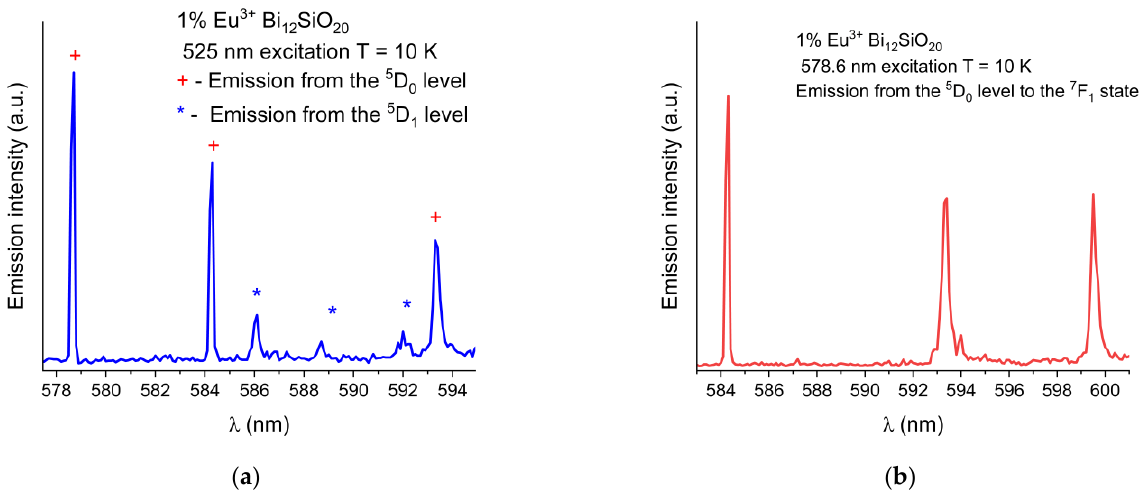
Figure 6. ( a ) Partial low-temperature (10 K) emission spectrum of Eu 3+ in BSO showing combined 5 D 0 and weak 5 D 1 emission lines under 525 nm excitation. ( b ) Emission from the 5 D 0 level to the 7 F 1 state, under resonant 5 D 0 level excitation at 578 nm, showing no lines present in 586 nm to 592 nm range.